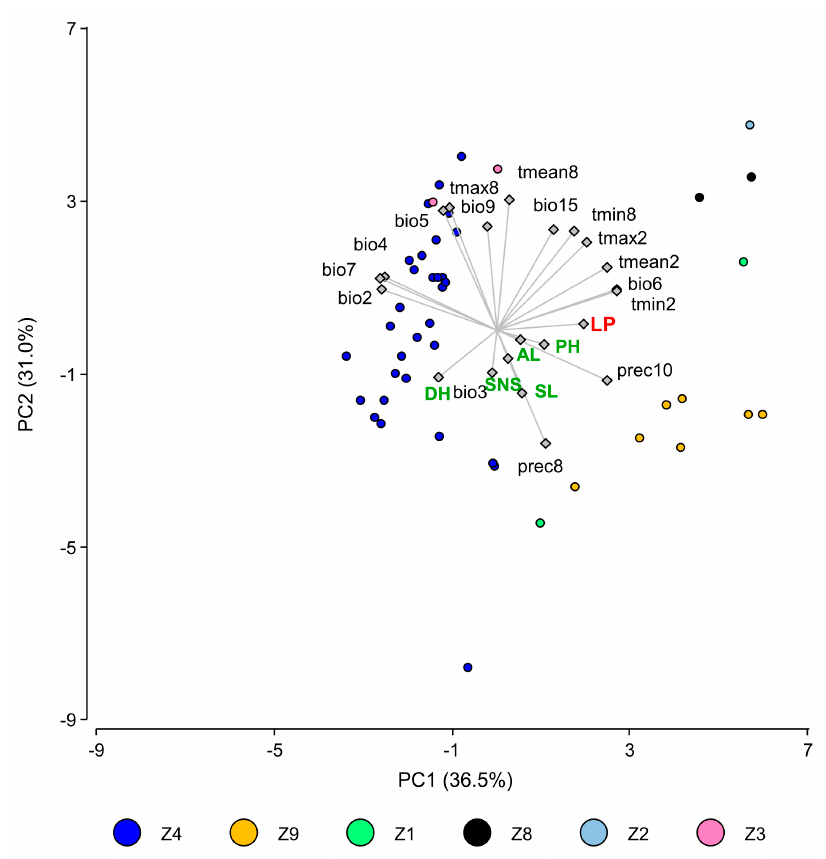
Figure 4. Biplot of the first two axes of the principal component analysis for the latency period at seedling stage (in red), the most significant bioclimatic variables (in black), and agronomic traits (in green). Agroecological zones are indicated in colors. Variables: bio2 = Mean daily temperature range, bio3 = Isothermality, bio4 = Temperature seasonality, bio5 = Maximum temperature of hottest month, bio6 = Minimum temperature of coldest month, bio7 = Annual temperature range, bio9 = Mean temperature of driest quarter, bio15 = Precipitation seasonality, tmean2 = February mean temperature, tmean8 = August mean temperature, tmax2 = February maximum temperature, tmax8 = August maximum temperature, tmin2 = February minimum temperature, tmin8 = August minimum temperature, prec2 = February precipitation, prec8 = August precipitation, AL = awn length, DH = days to heading, LP = latency period, PH = plant height, SL = spike length, SNS = spikelets per spike.